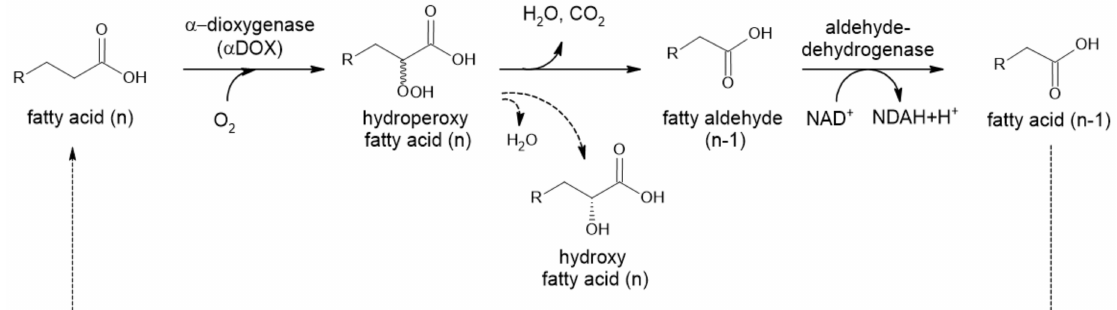
Figure 5. α -Oxidation in plants. Chemical decomposition of hydroperoxyl fatty acid to CO 2 and aldehyde is caused by intramolecular mechanism. When reduction takes place, only D-isomer is detected (Adapted with permission from ref. [45]. Copyright 2014